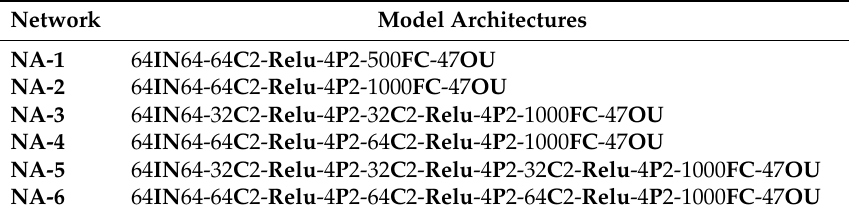
Table 1. Various network architectures of deep convolutional neural network